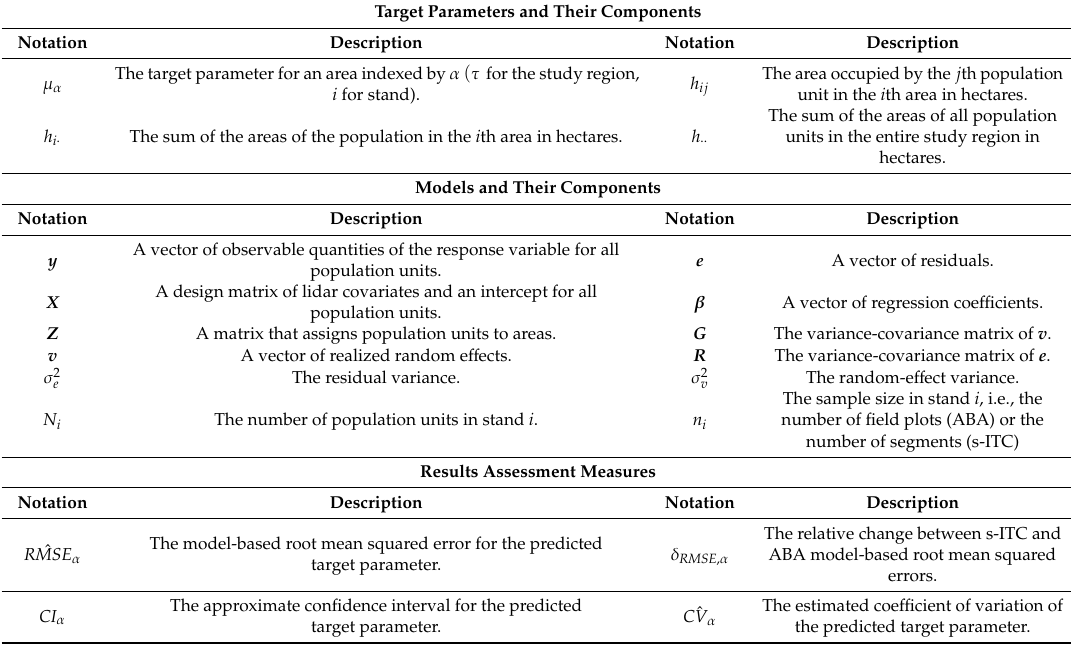
Table A1. Glossary of major notation for target parameters and the unit-level